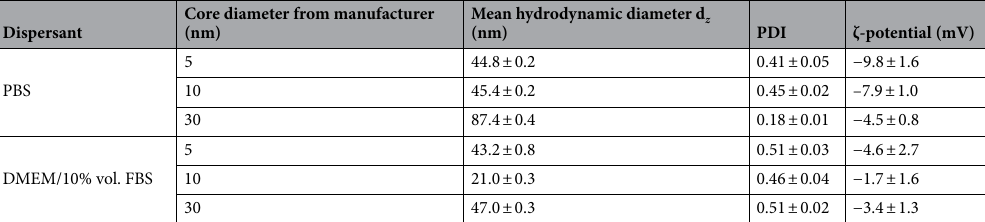
Table 1. The values of the mean hydrodynamic diameter (d z ), polydispersity index (PDI), and ζ-potential at 298 K for examined IONPs (c IONPs = 0.01 mg/mL) dispersed in PBS and DMEM with 10% vol. FBS at pH 7.4 (values are the mean ± standard